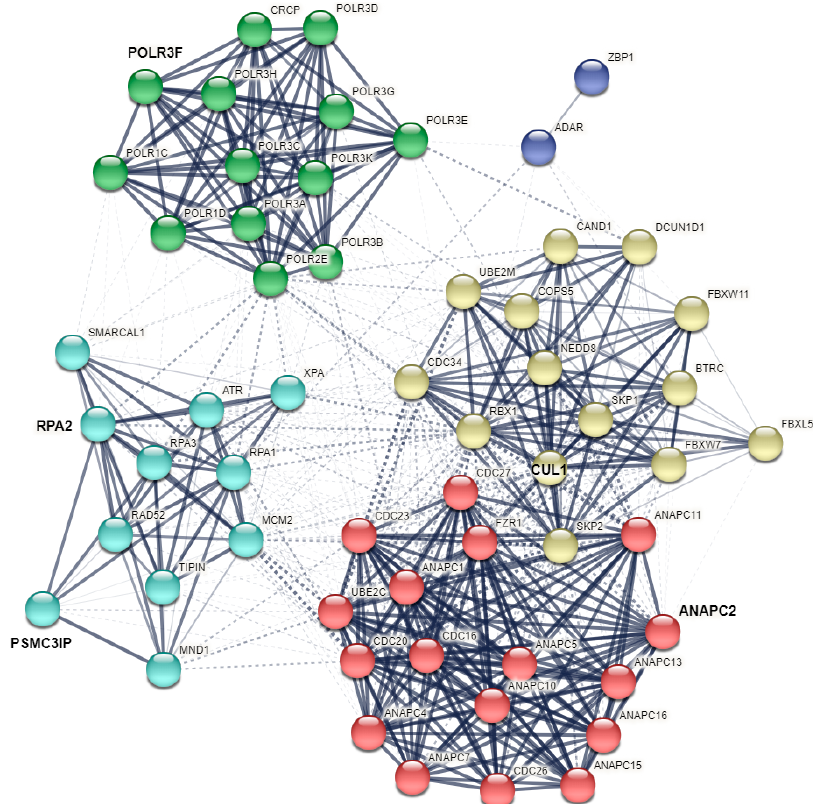
Figure 6. STRING interaction network of newly identified human possible Z-DNA/Z-RNA binding proteins (in bold and higher letter size), together with 2 previously known human Z-DNA/Z-RNA binding proteins (ZBP1 and ADAR), and also with 50 first shell interactors. Clustering was made using MCL inflation parameter (3), the resulting five clusters are highlighted in distinct colours. Line thickness indicates the strength of data support and edges between different clusters are dotted.